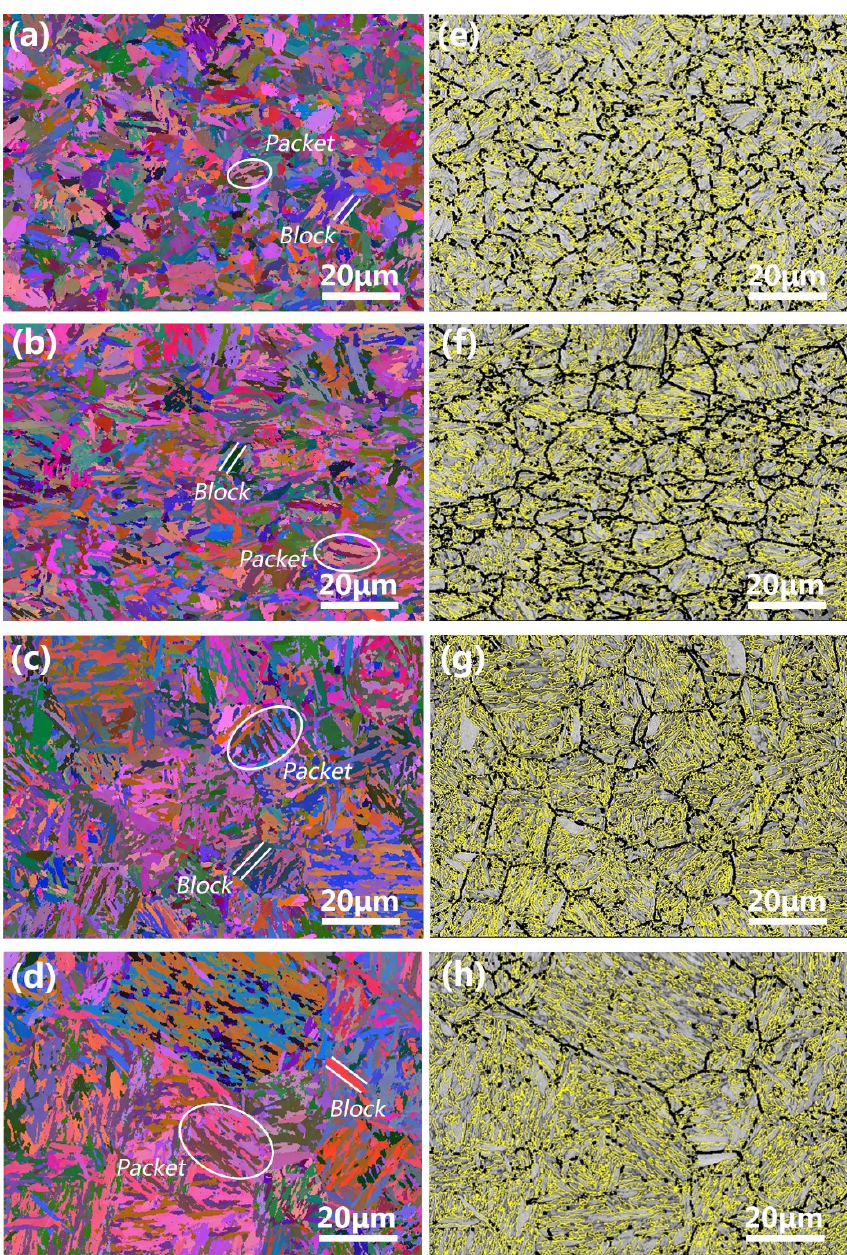
Fig. 4. EBSD All Euler maps and the corresponding Band Contrast maps of MCLA martensitic steel 115 Figure 4. Electron backscattered di ff raction (EBSD) of all Euler maps and the corresponding band austenitized at different temperatures of (a) and (e) 850 °C; (b) and (f) 880 °C; (c) and (g) 910 °C; (d) 116 contrast maps of MCLA martensitic steel austenitized at di ff erent temperatures of ( a , e ) 850 ◦ C; and (h) 940 °C (black line: 45° > θ > 15°; and yellow line: θ > 45°). 117 ( b , f ) 880 ◦ C; ( c , g ) 910 ◦ C; ( d , h ) 940 ◦ C (black lines: 45 ◦ > θ > 15 ◦ ; and yellow lines: θ > 45 ◦